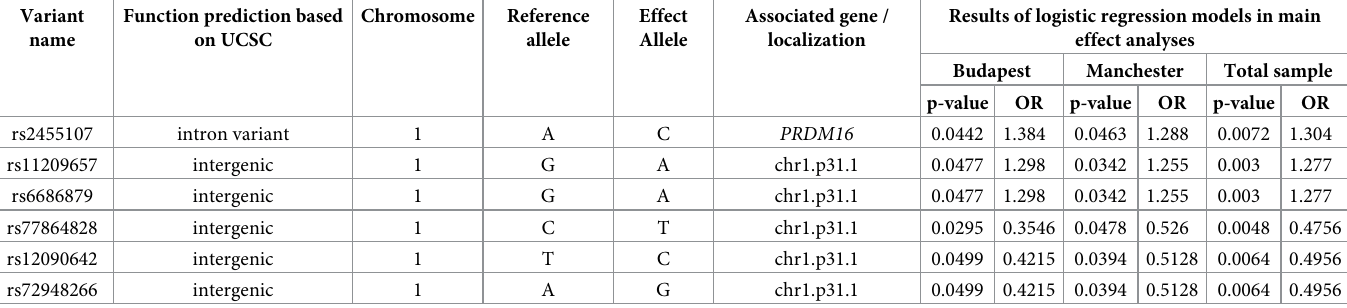
Table 1. Significant genetic polymorphisms in main effects logistic regression analysis for migraine in the subsamples (Budapest, Manchester) and the total sample.